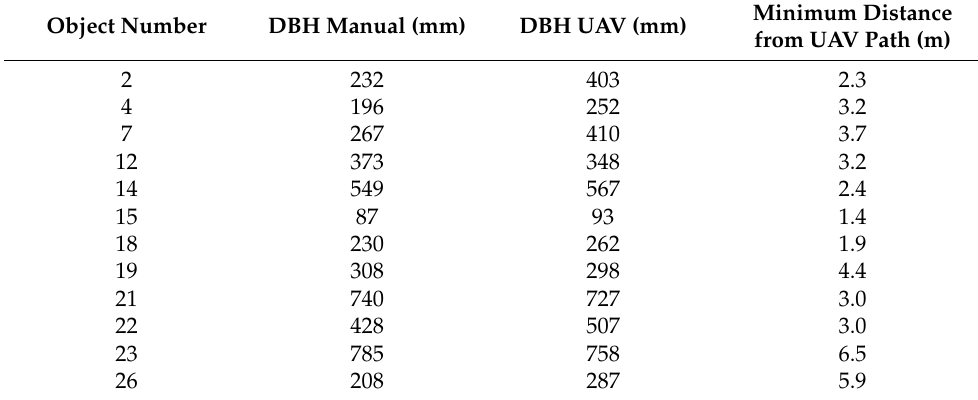
Table 1. Summary data for the 12 accurately detected objects in the study area (object numbers correspond to those in Figure